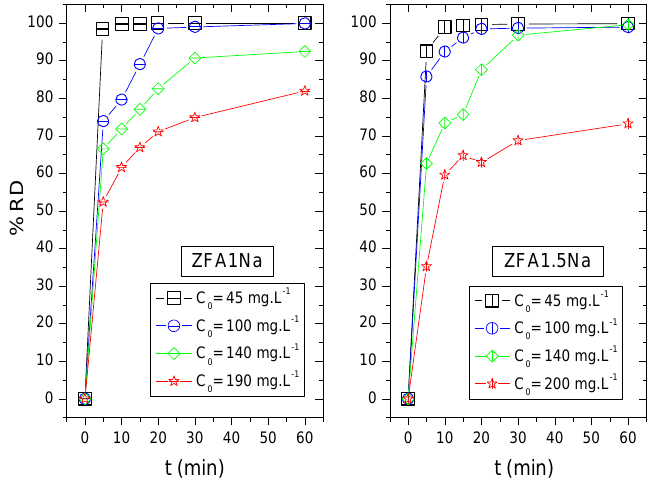
Figure 4. The removal degree (%RD) of ZFA1Na and ZFA1.5Na zeolites (dosage of 0.5 g · L − 1 ) as a function of the initial Cu(II) concentration (45–200 mg · L − 1 ).